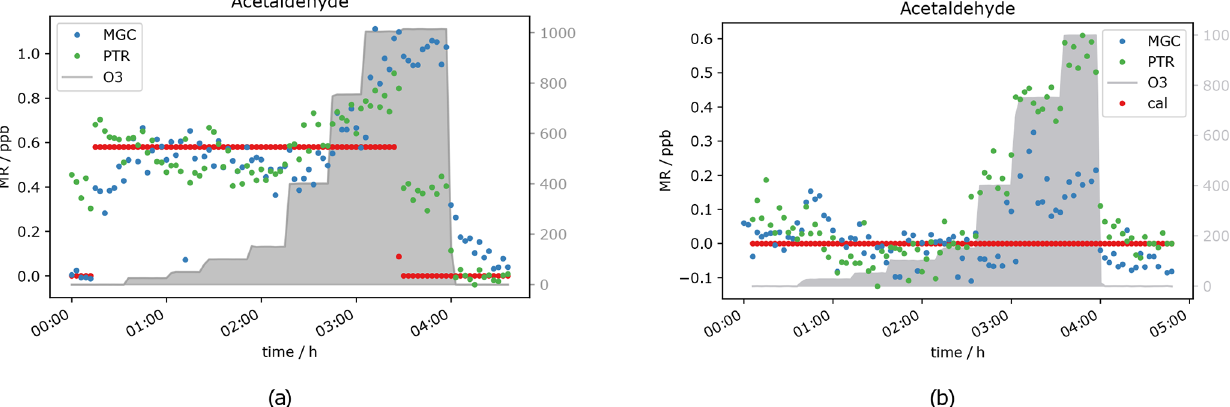
Figure 4. Acetaldehyde mixing ratios at seven different ozone levels between 0 and 1000ppb and one standard gas level. VOC levels are 0ppb (a) and 0.5ppb (b) .